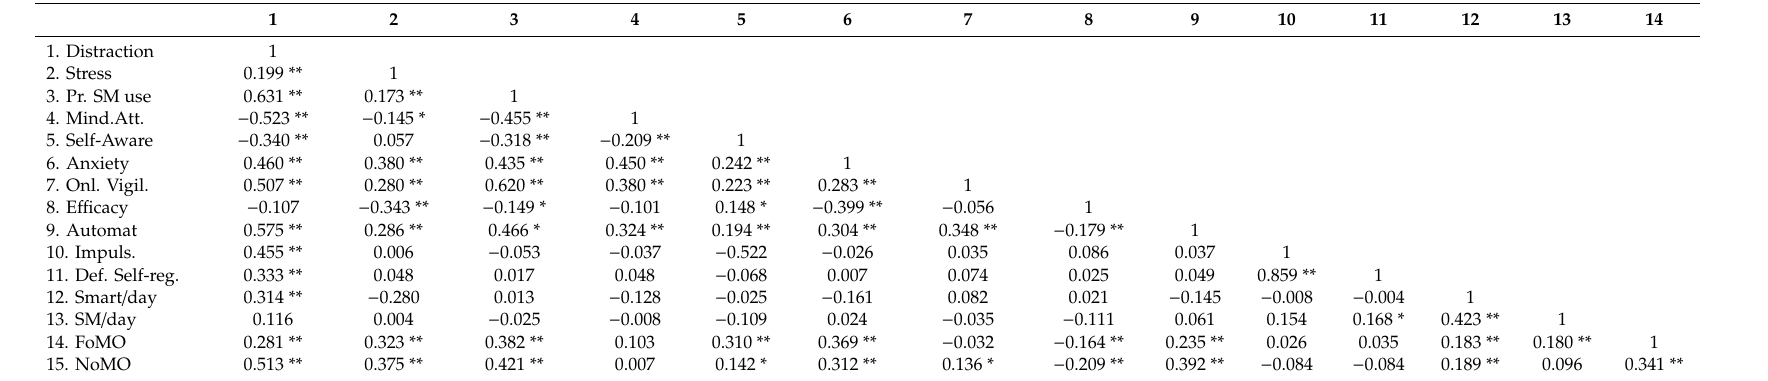
Table 3. Bivariate Pearson’s r correlation